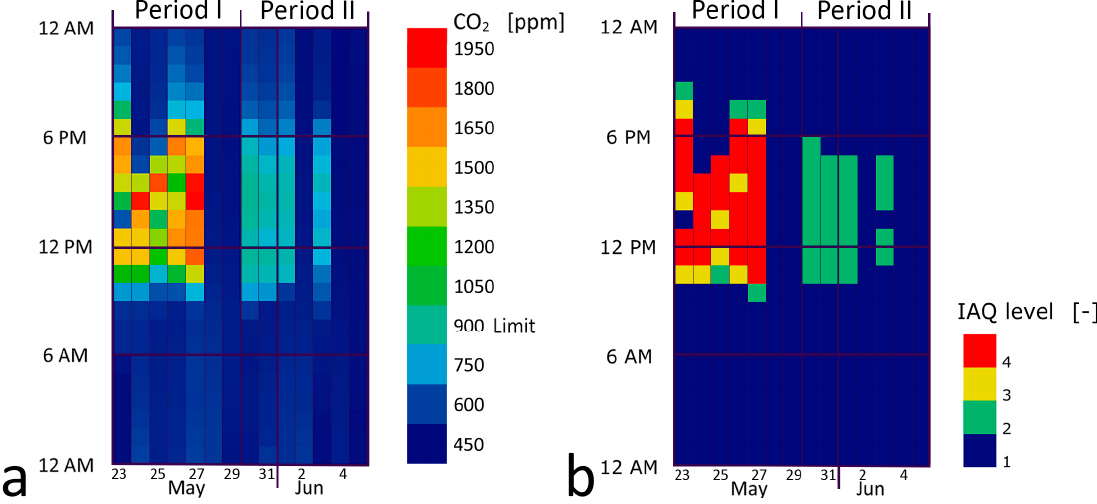
Figure 11. Hourly average data for manual control (period I, 23–29 May) and automatic control (period II, 30 May–5 June): ( a ) CO 2 concentration; ( b ) indoor air quality level.